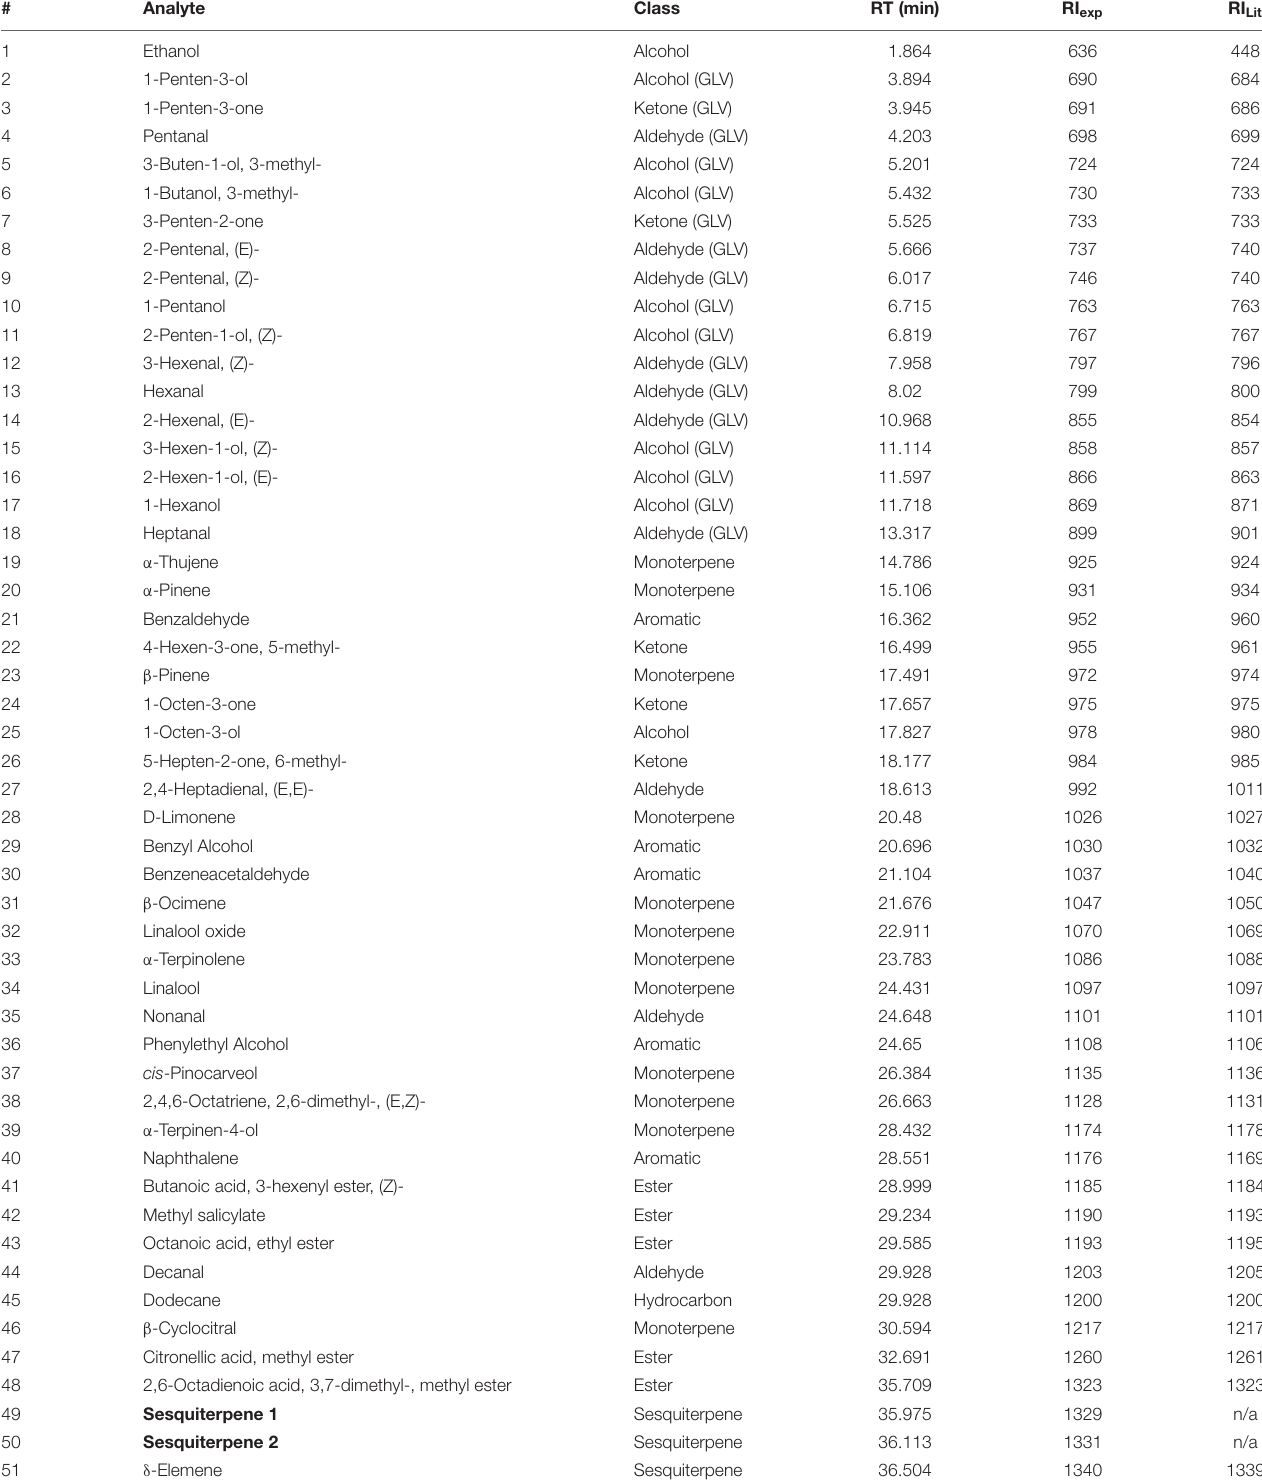
TABLE 1 | Metabolites tentatively and positively identified in the headspace of galled and non-galled leaves of Myrcia